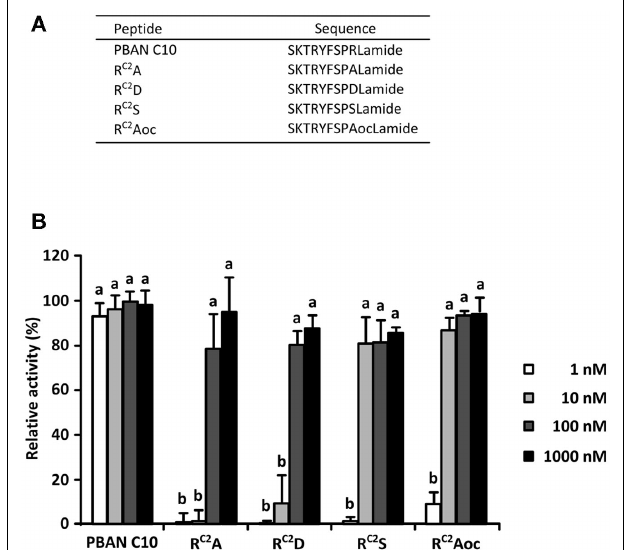
FIGURE 1 | Pheromone biosynthesis-activating neuropeptide-like activities of R C2 X peptides. (A) Amino acid sequences of the R C2 X peptides. (B) Dose dependency of PBAN-like effects of the R C2 X peptides measured via a Ca 2 + imaging technique with Fura Red as the Ca 2 + indicator. Bars represent the mean + SD of five replicates. Different letters (a and b) indicate significant difference at P < 0.05 by theTukey–Kramer test.